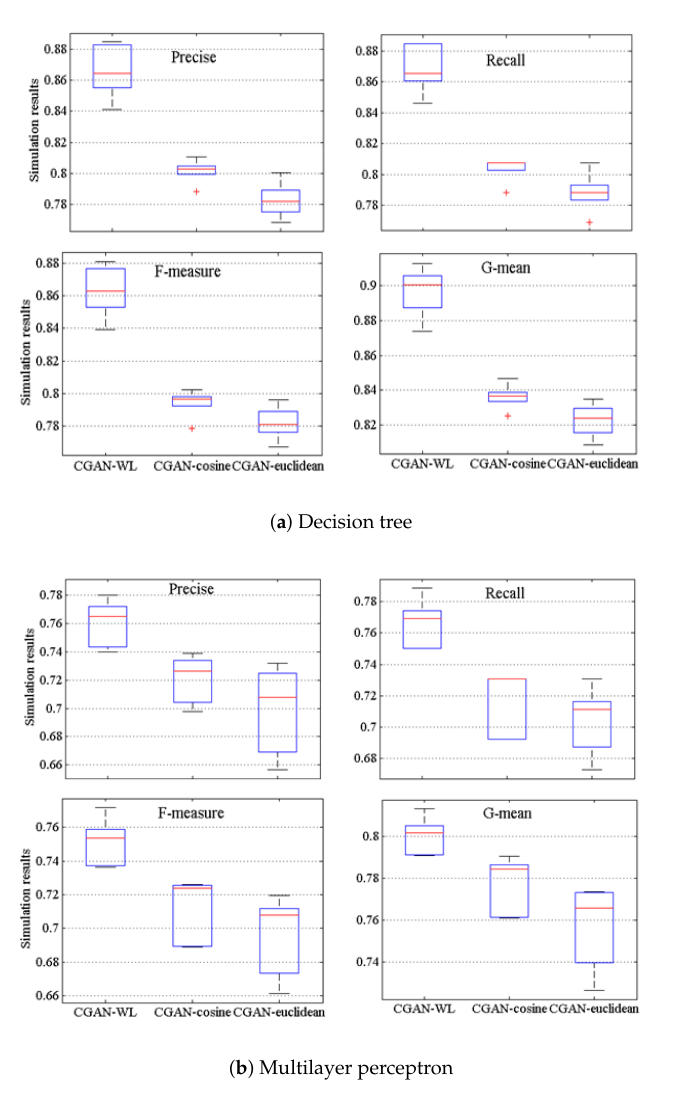
Figure 9. Comparison of different labeling strategies for generated data from our CGAN-based model. ( a ) Classifying the tagged samples with decision tree. ( b ) Classifying the tagged samples with multilayer